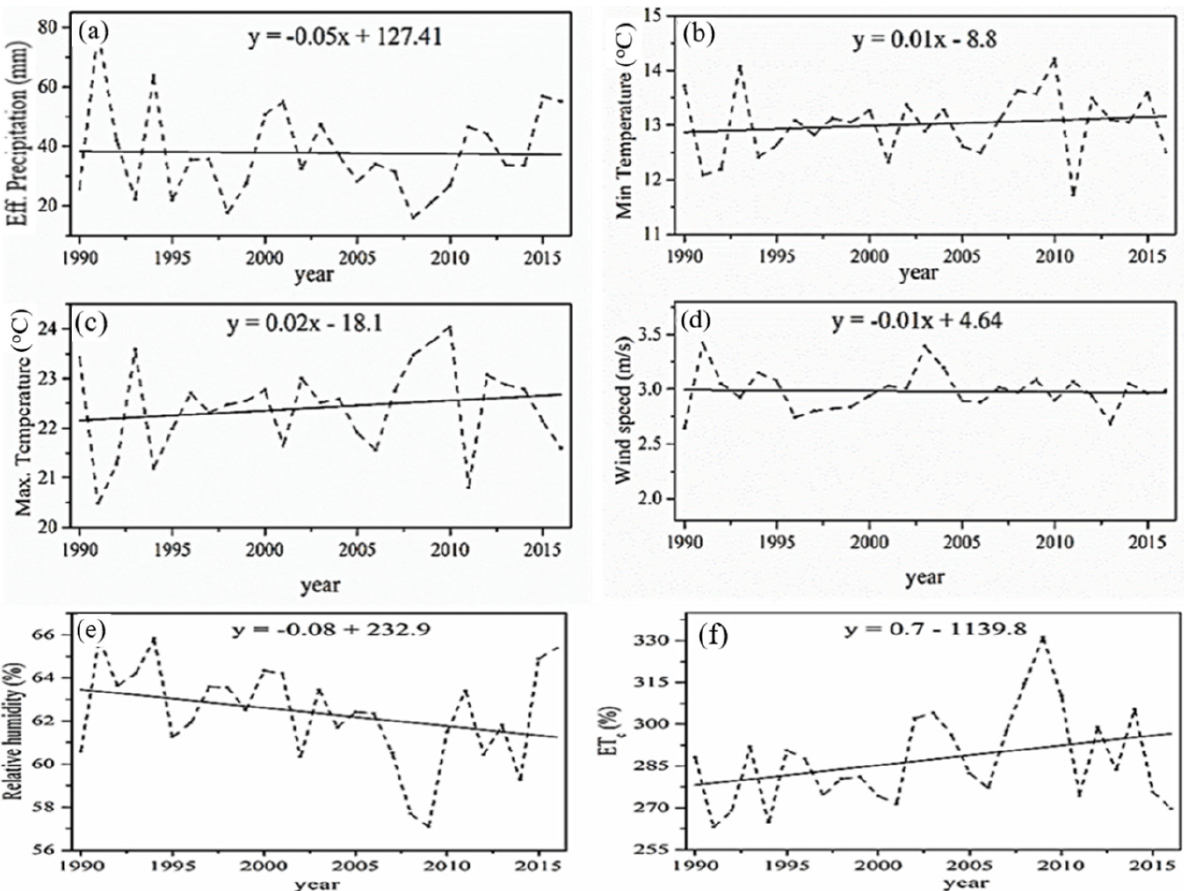
Figure 2. Seasonal variations from 1990 to 2016: “( a )” effective precipitation, “( b )” min. temperature, “( c )” max. temperature, “( d )” wind speed, “( e )” relative humidity, and “( f )” crop evapotranspiration.